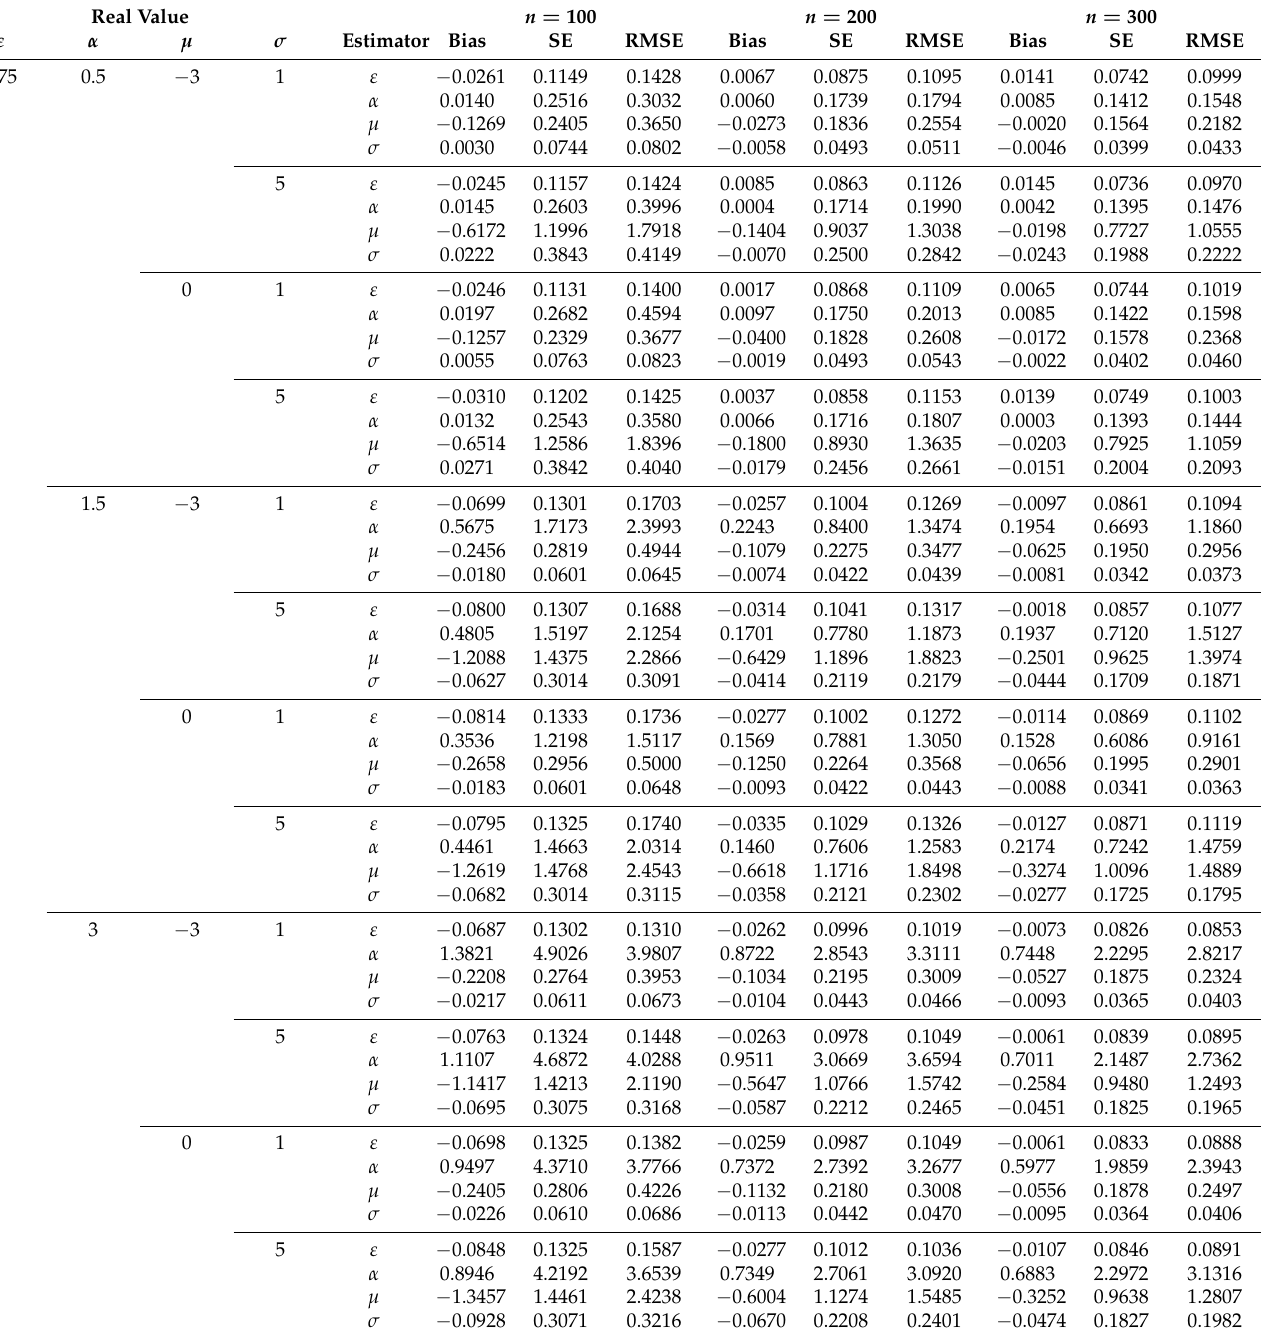
Table 3. Recovery parameters for the ML estimators in the BESN: case ε =